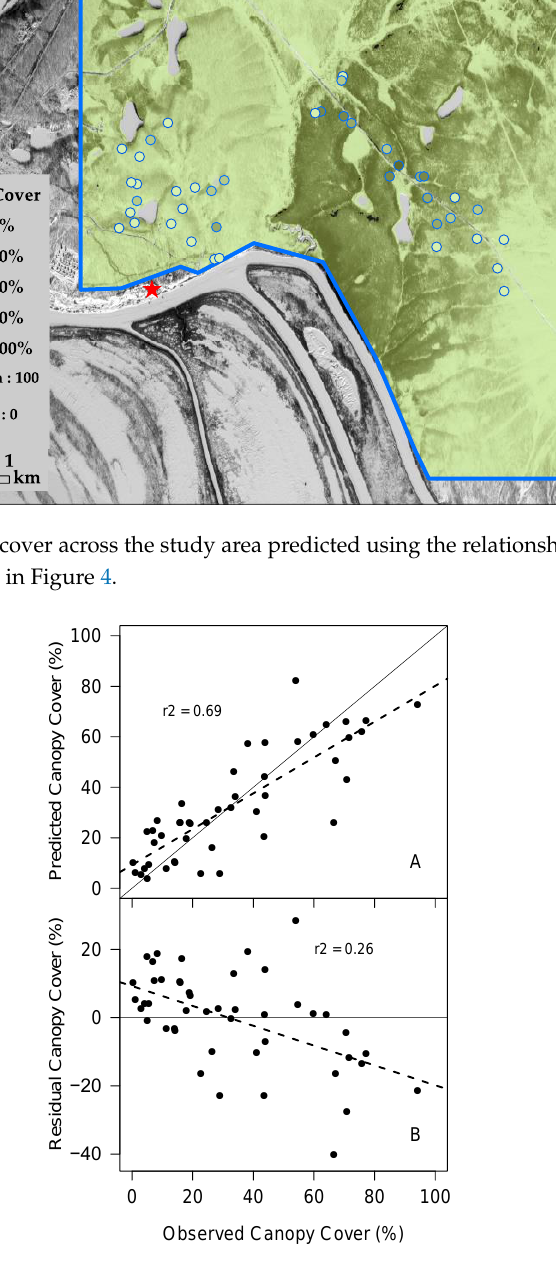
Figure 6. Relationship between observed and predicted canopy cover ( A ), and between observed and residual canopy cover ( B ). Dashed lines show regression fits, thin solid lines indicate 1:1 lines ( A ), and abscissa ( B ). Table 1. Phenology differences between overstory larch trees and understory Betula and Salix shrubs for the 2000–2017 period. Values in parentheses represent one standard deviation. SOS